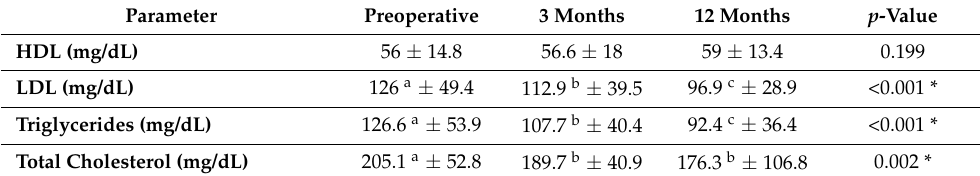
Table 2. Comparison of lipid profiles across a 12-month period postoperatively (n = 160).